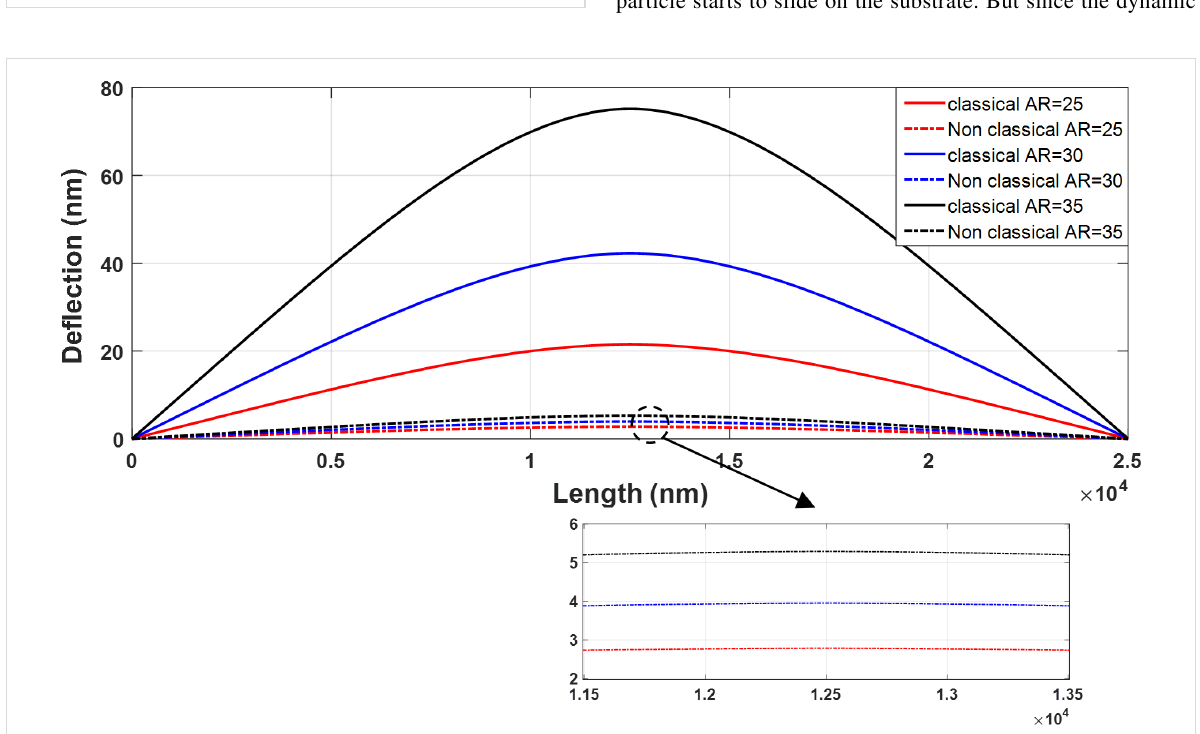
Figure 10: Sensitivity of classical and nonclassical Timoshenko beam model deflections to the change in aspect ratio.